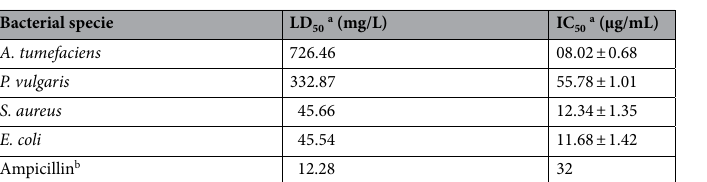
Table 1. Antioxidant activity (DPPH) and IC 50 value in ACE and Ag. NPs. a IC 50 = Signifies the means (± standard error) of 3 equivalent amounts (p < 0.05). b Reference.